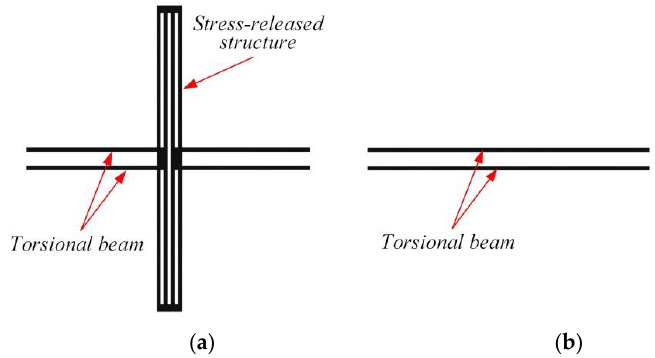
Figure 4. Simplification of stress-released structure: ( a ) Original model; ( b ) Simplified model.